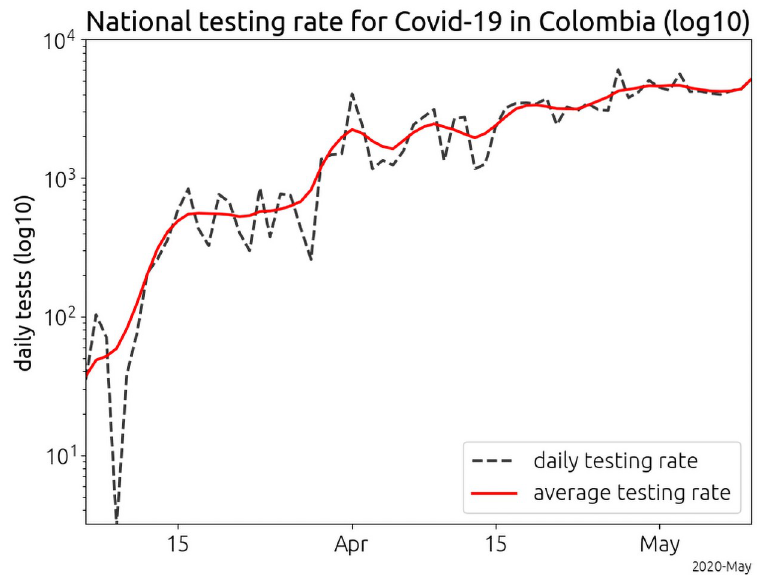
Fig 1. Average testing rates in Colombia, March through early May. The number of daily tests for SARS-CoV-2 increased by two orders of magnitude over two months. The testing rates shown are a running average computed with a centered, seven day window. We have identified dynamic testing rates as a key confounding factor in the analysis of COVID-19 case data.